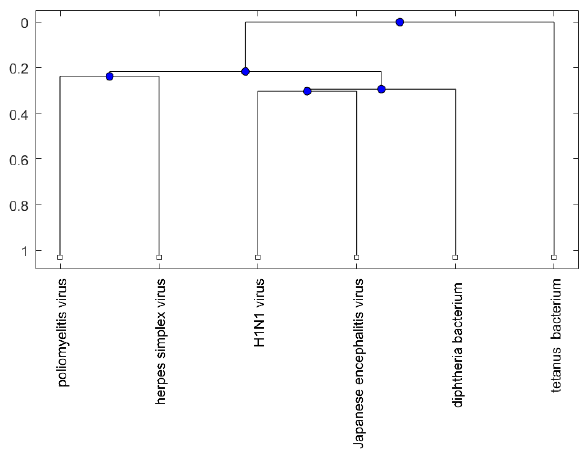
Figure 4. The phylogenetic tree of virus or bacterium based on the Juke–Cantor distance and single linkage function.